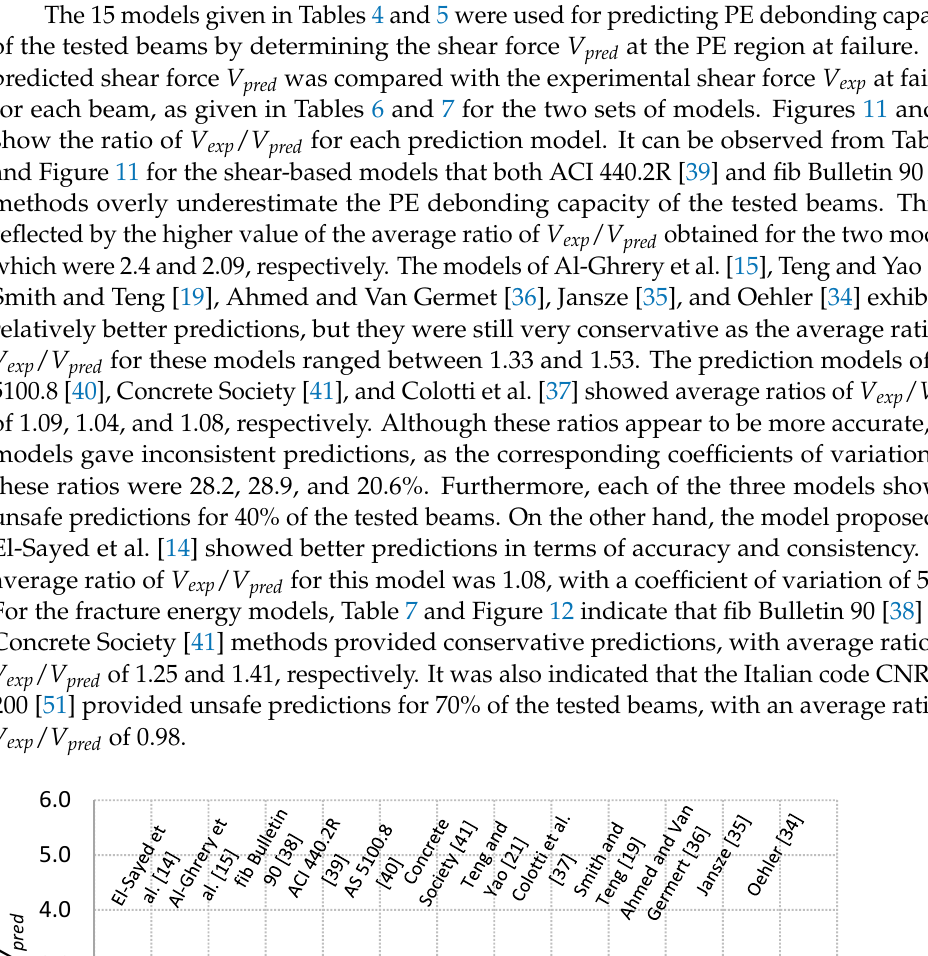
Figure 12. Comparison of experimental and predicted plate end debonding capacity using fracture energy-based models.